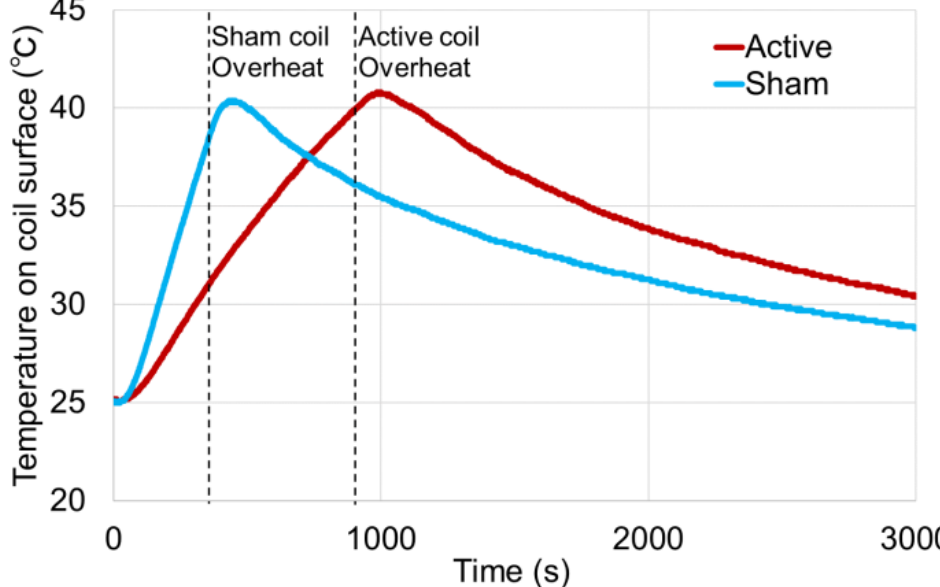
Figure 6. Relationship between coil surface temperature and time course of 0.5 Hz continuous stimulation in the active and sham coils. The horizontal axis indicates the time of measurement from the start of stimulation and the vertical axis shows the surface temperature of the coil. The stimulation was performed with 50% MSO, continuous single-pulse stimulation. The red line shows the temperature change of the active coil while the blue line indicates the temperature change of the sham coil. The dashed line shows the timing when each coil automatically stopped stimulation as a safety measure due to temperature increase.